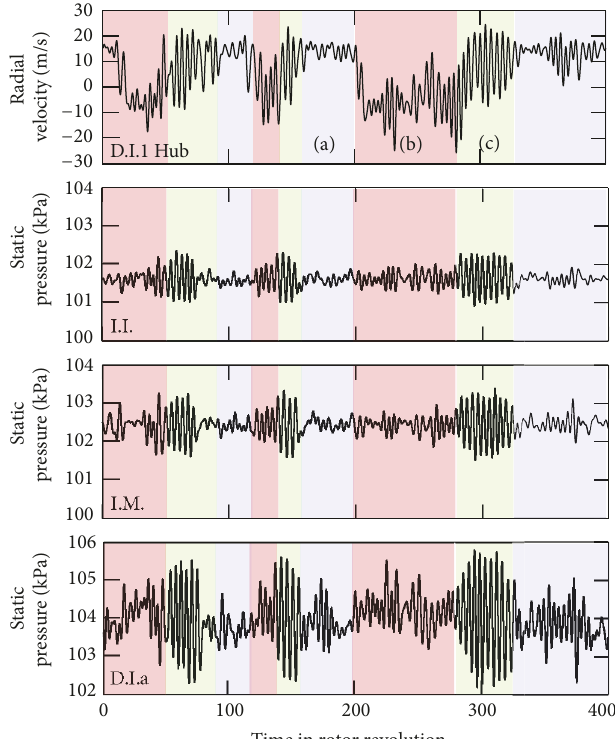
Figure 18: Radial velocity at diffuser inlet and static pressure traces at meridional direction ( 𝜙 = 0.10, 30 Hz low-pass filter).